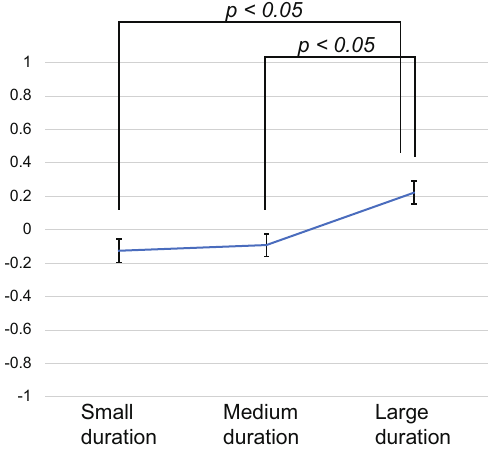
Figure 7. Results of Experiment 2. Scores for each stimulus